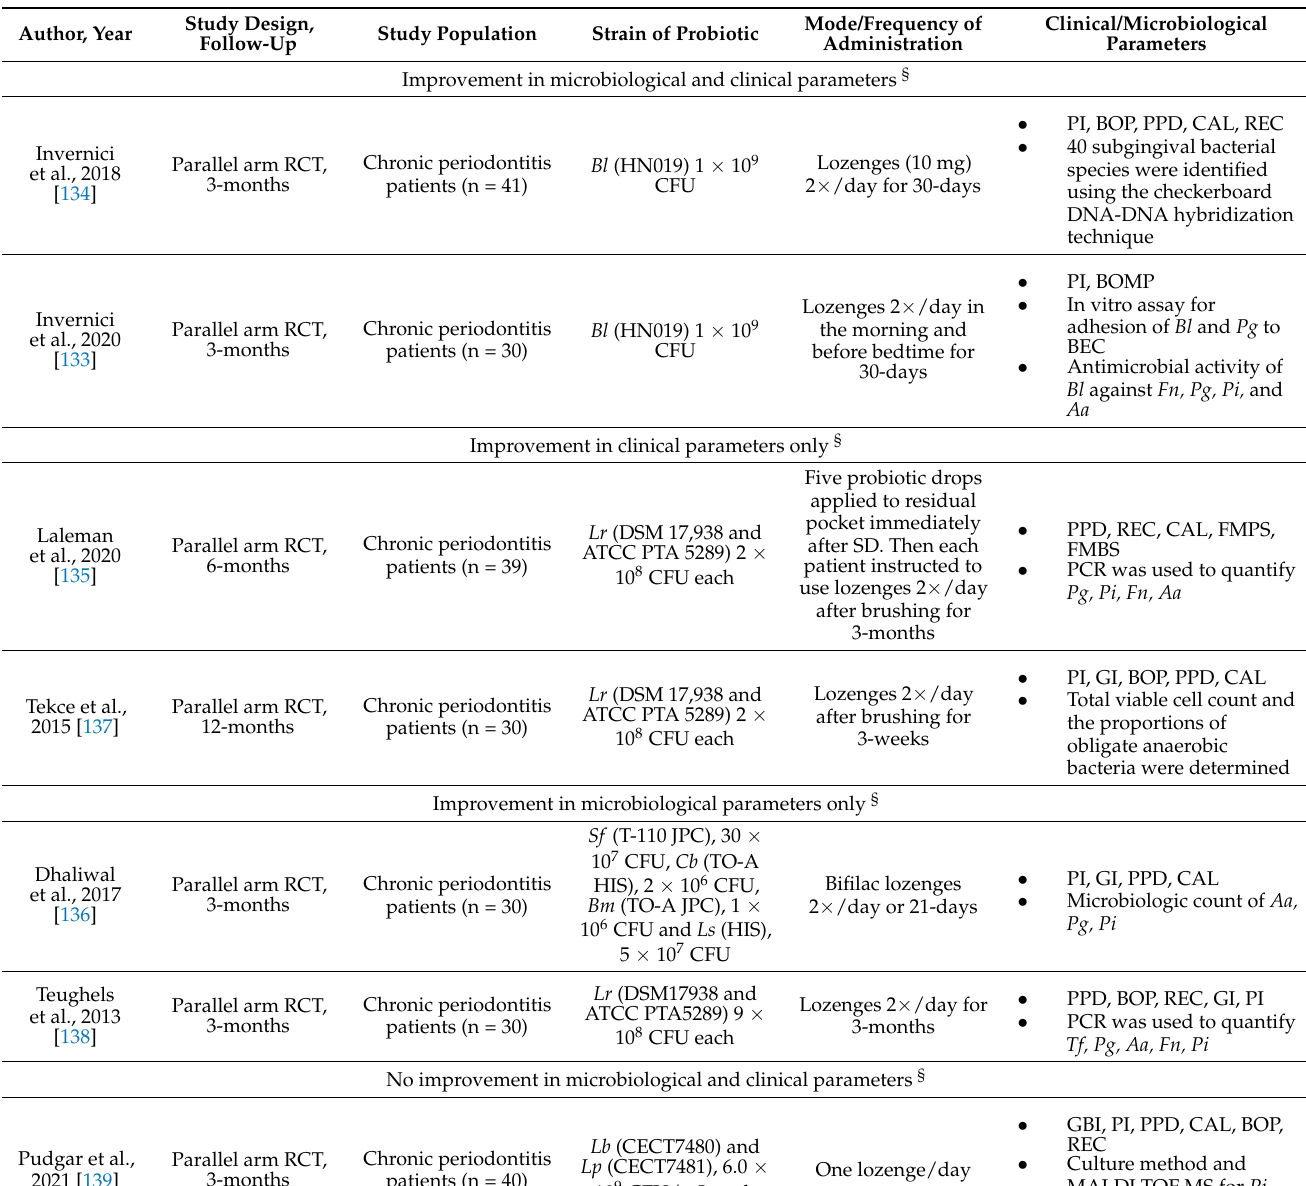
Table 5. Efficacy of probiotics as an adjunct to nonsurgical periodontal therapy on microbiological and clinical